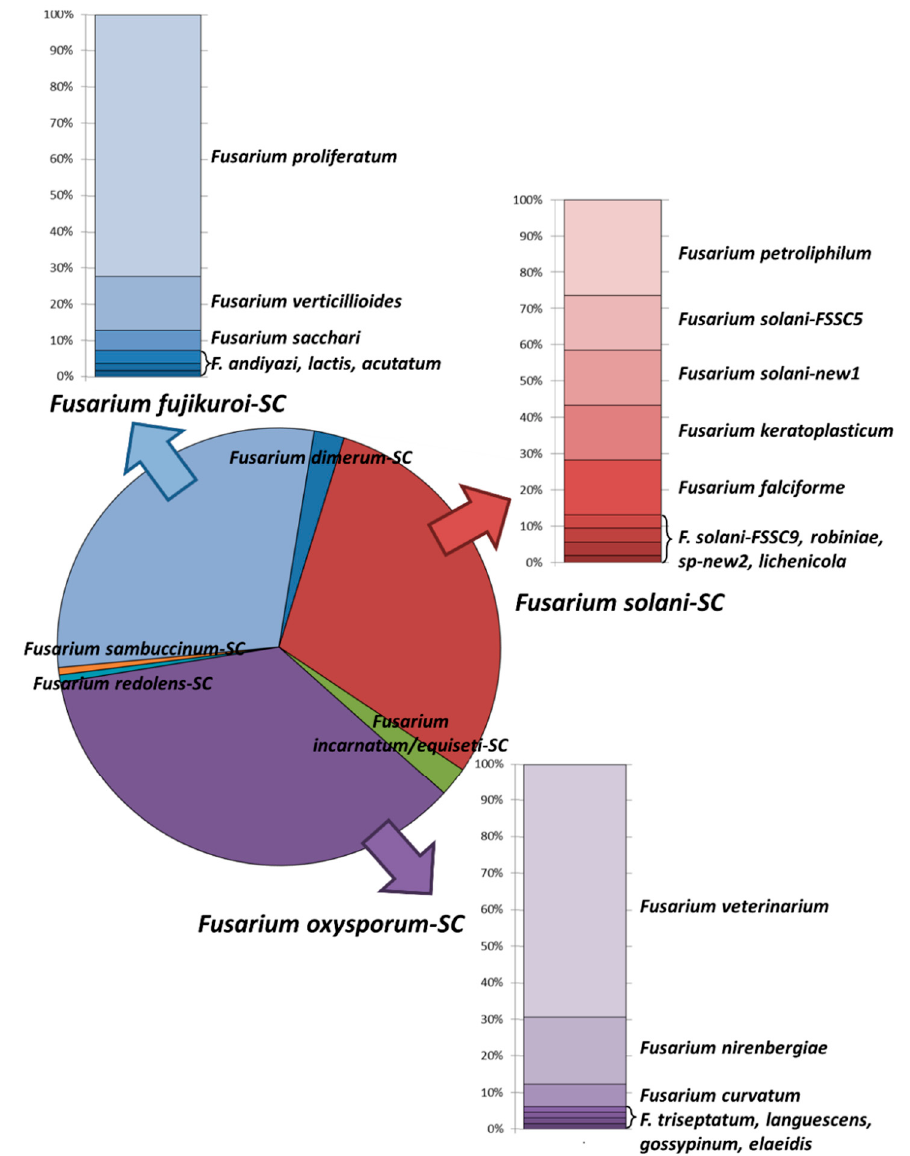
Figure 3. Species distribution of 182 Fusarium spp. isolates identified in 20 European centers during a one-year prospective study.